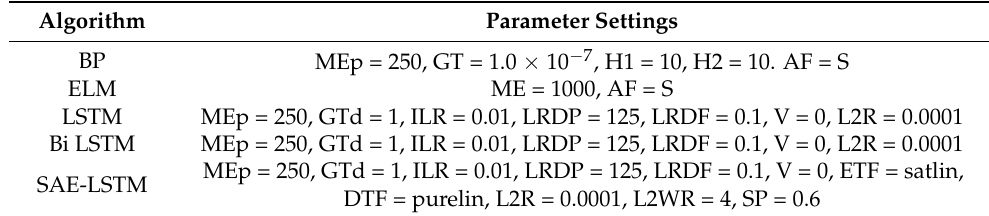
Table 3. Parameter setting of the neural